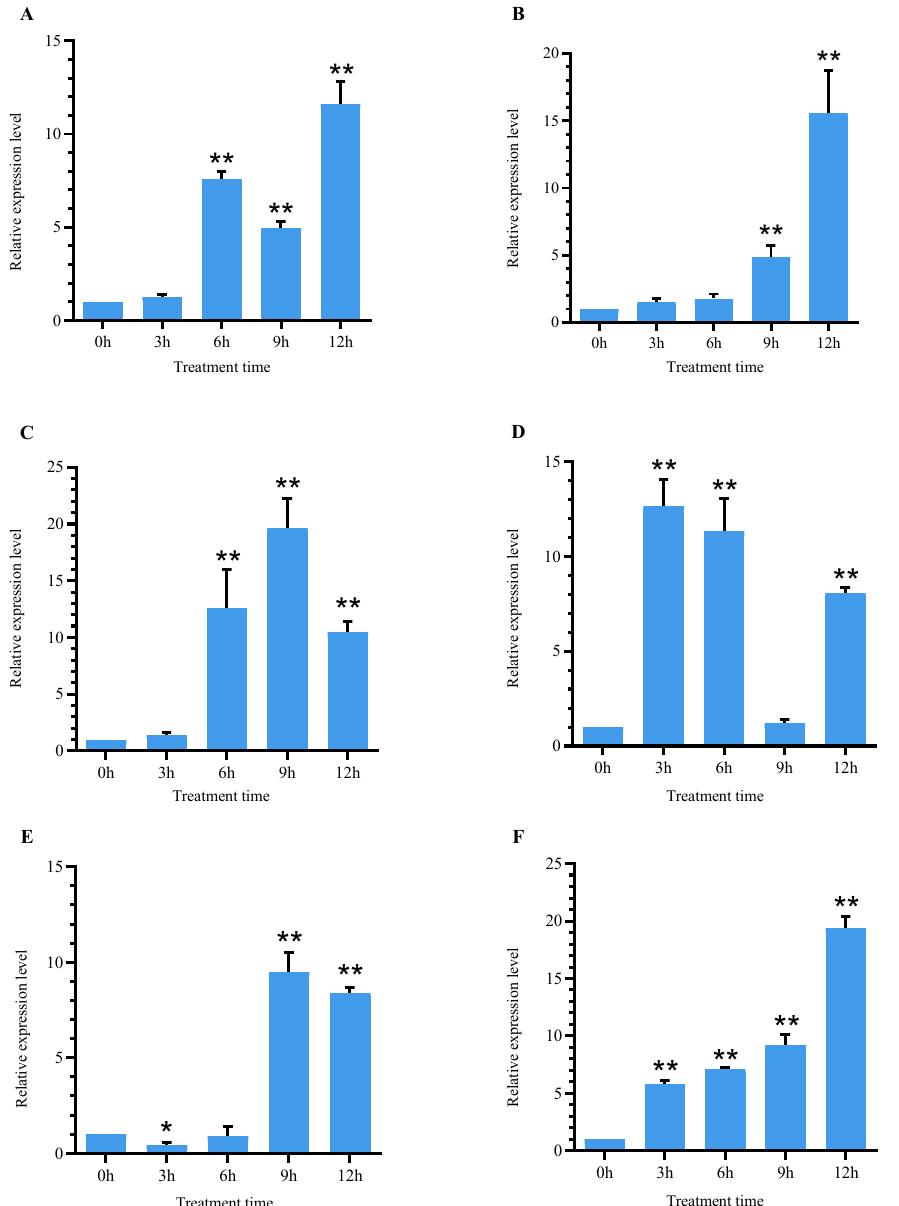
Figure 7. Expression analysis of SlSGR2 in tomato leaves and roots under cadmium treatment: ( A ) 25 µ M CdCl 2 in leaf; ( B ) 25 µ M CdCl 2 in root; ( C ) 50 µ M CdCl 2 in leaf; ( D ) 50 µ M CdCl 2 in root; ( E ) 100 µ M CdCl 2 in leaf; ( F ) 100 µ M CdCl 2 in root. For data statistical significance, Student’s t -test was performed; p < 0.05 was considered statistically significant (* <0.05 and ** <0.01).